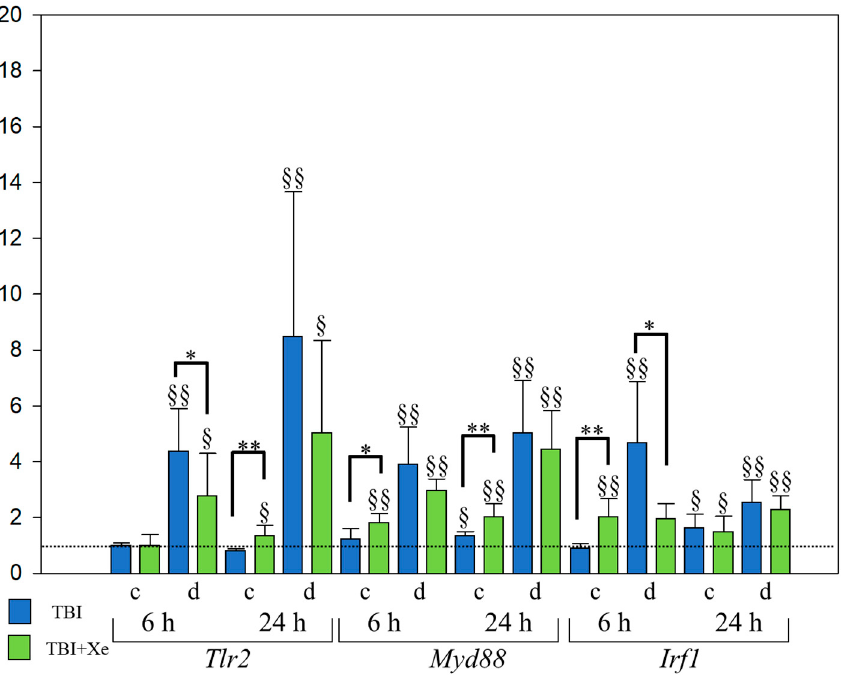
Figure 3. Inflammatory gene expression in the rat brain tissue with TBI. TBI vs. TBI + Xe : * p <0.05, ** p <0.00055; § p <0.05, §§ p <0.00055, compared to intact animals. One-way ANOVA, Holm-Sidak method.